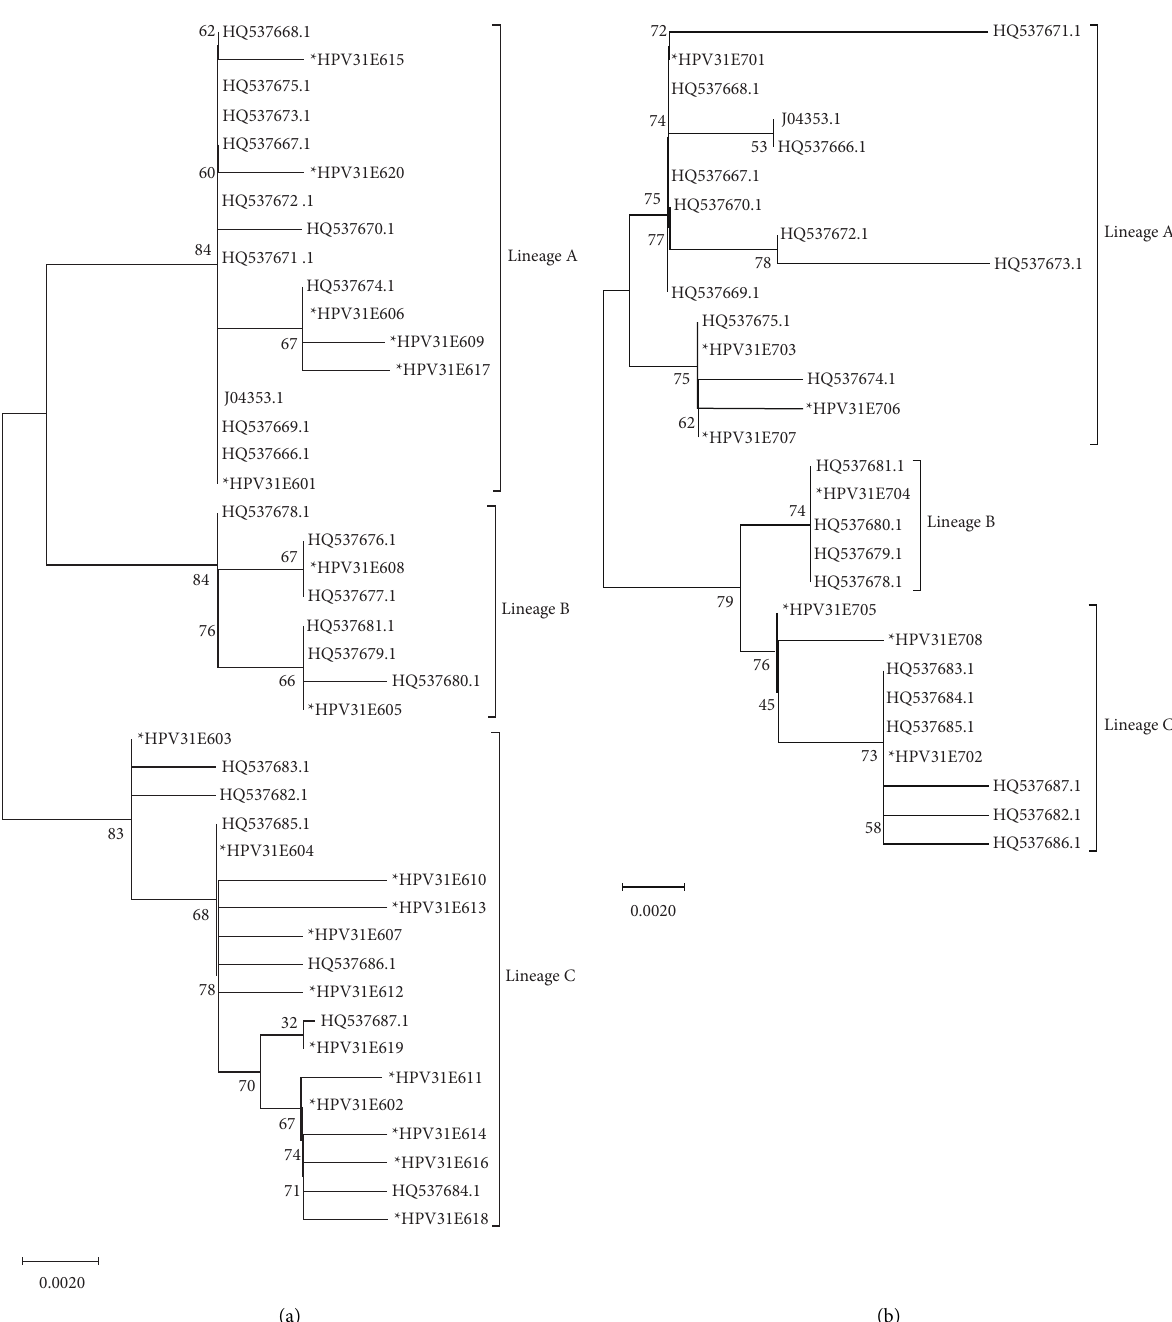
Figure 3: (a) Te neighbor-joining tree of HPV31E6. ∗ represents the sequences obtained in this study. Others were the variants reported previously in NCBI. Numbers above the branches are the bootstrap values. (b) Te neighbor-joining tree of